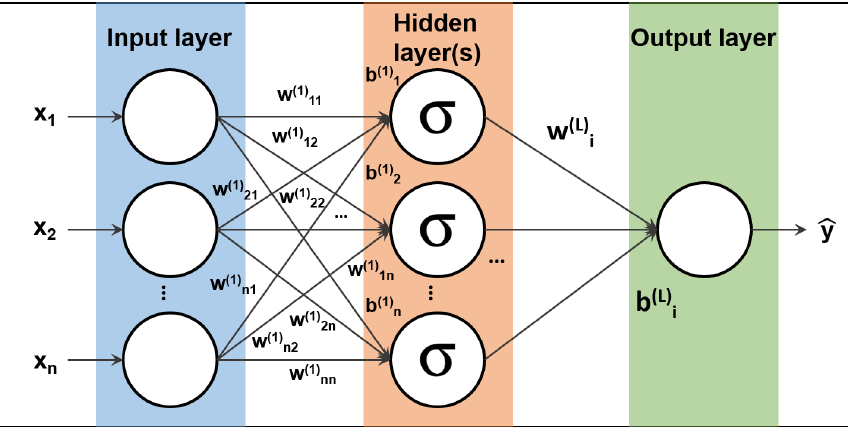
Figure 1. The block diagram describing the methodology of the proposed FFNN method.